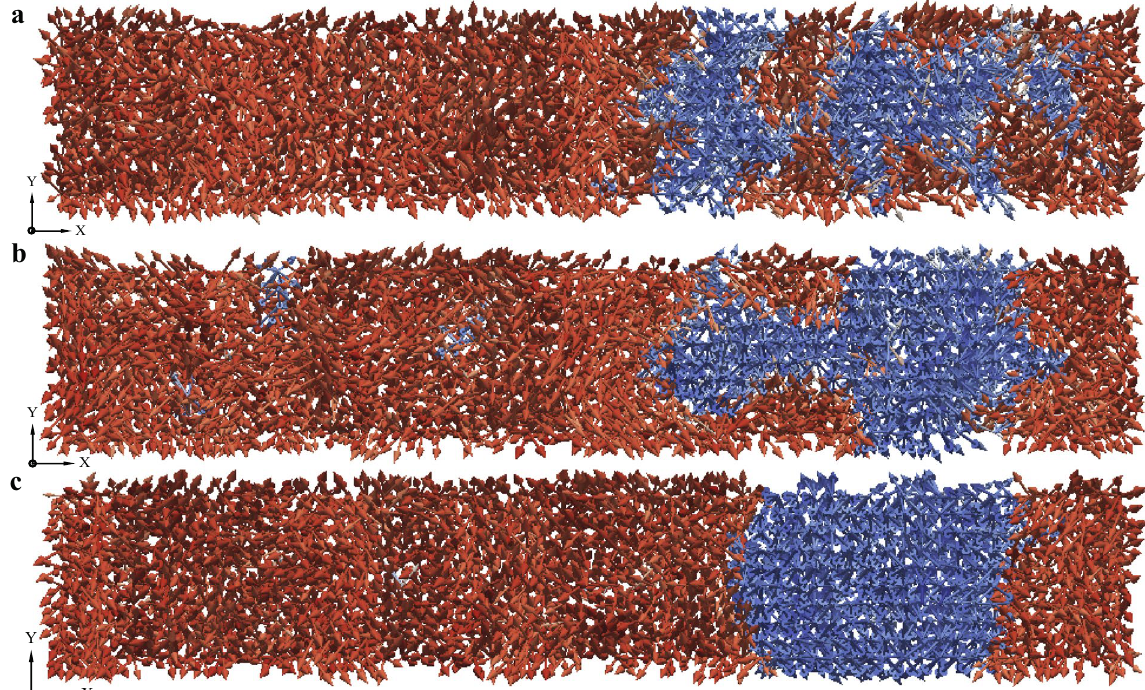
Figure 6. Domain pattern revealing domain diffusion. ( a ) At t = 9.2 ps the domain pattern shows nucleated domains under a field of 35 MV/m, exactly at this instance the electric field is removed. ( b ) At t = 21.2 ps the nucleated domains appear to diffuse in the absence of the electric field. ( c ) By t = 51.2 ps the nucleated domains have completely diffused into the growing domain and the resulting domain pattern continues to remain unchanged.